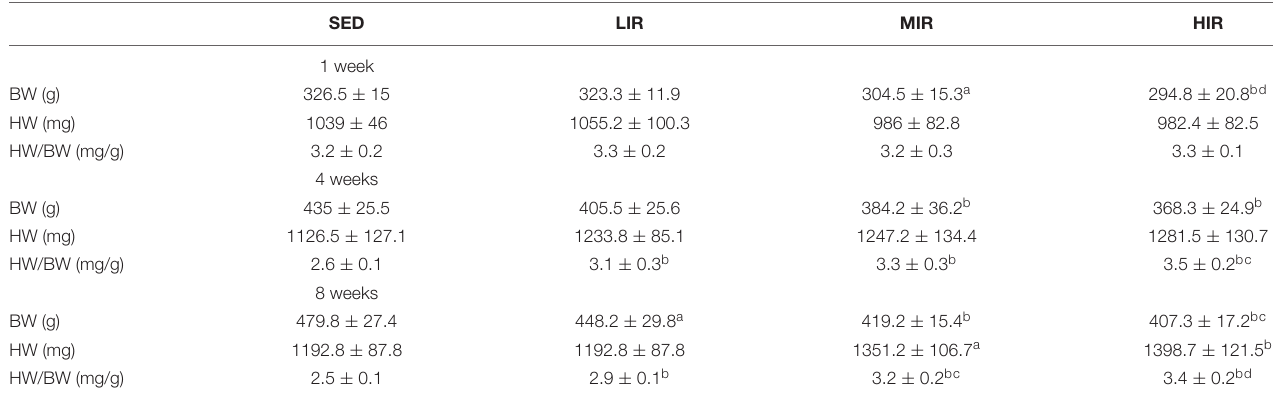
BW body weight, HW heart weight, HW/BW heart weight/body weight ratio. Data are presented as means ± SEM. a P < 0.05 vs. SED. b P < 0.01 vs.